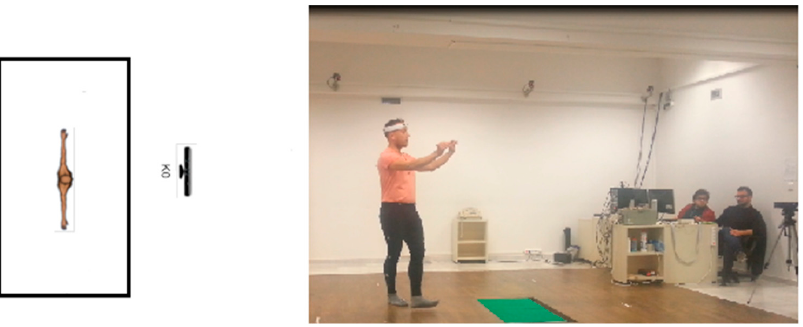
Figure 1. The dance capturing process. Image on the left demonstrates the sensor position. On the right, we can see the dancer while acting.